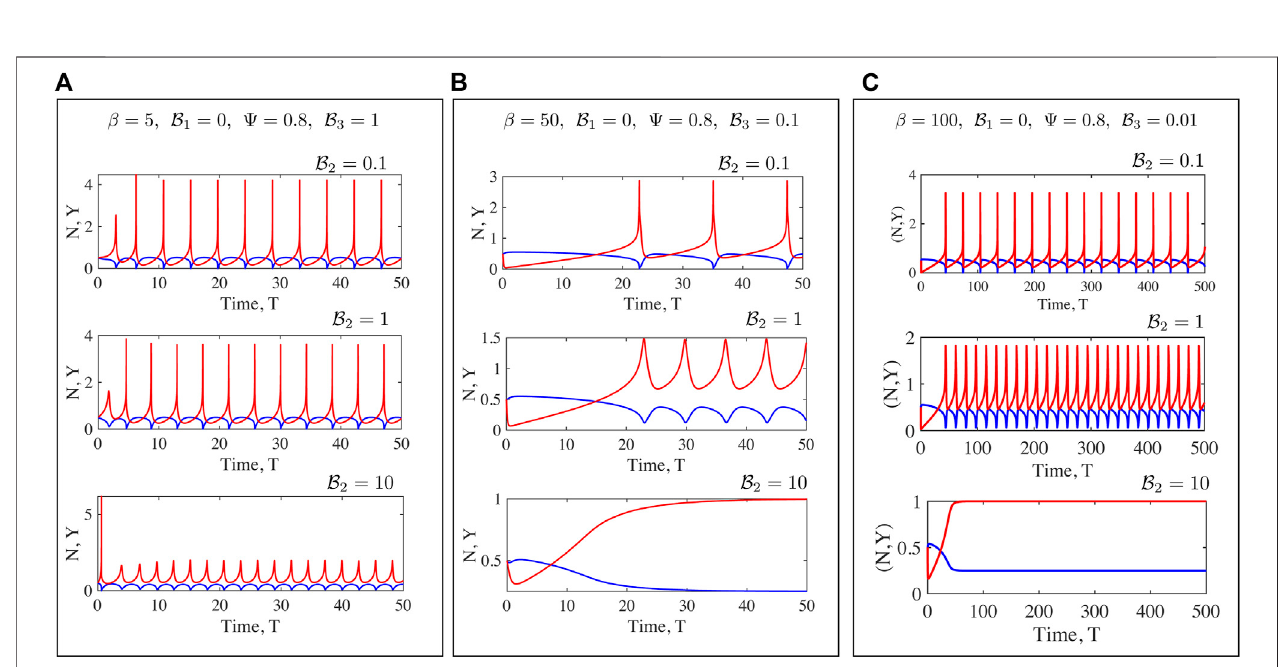
FIGURE8| Fullynon-linearsolutionsfortheMaxwellmedium.Heretofocusontherheologicalparameters B 2 and B 3 ,westudysolutionsforconstant Ψ (=0.8)with F (cid:2) cosh ( E ) (here E (cid:2) 2 . 0 for all cases). Results are shown for increasing values of β (from left to right) (A – C) and increasing values of B s Y s